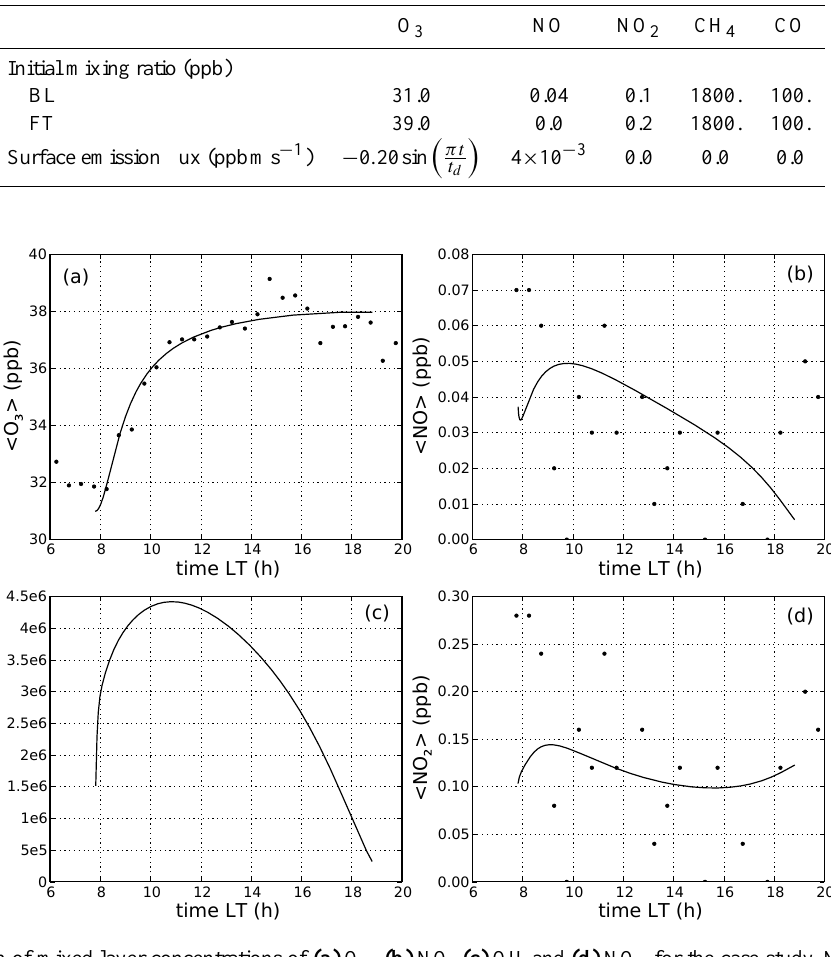
Fig. 4. Diurnal evolution of mixed layer concentrations of (a) O 3 , (b) NO, (c) OH and (d) NO 2 for the case study. NO 2 measurements are scaled down to match the NO 2 /NO ratio of 5 obtained during summer 2010 from more reliable measurements than those from August 2001. Dots indicate measurements from the tower at 67.2m. Model results are indicated by